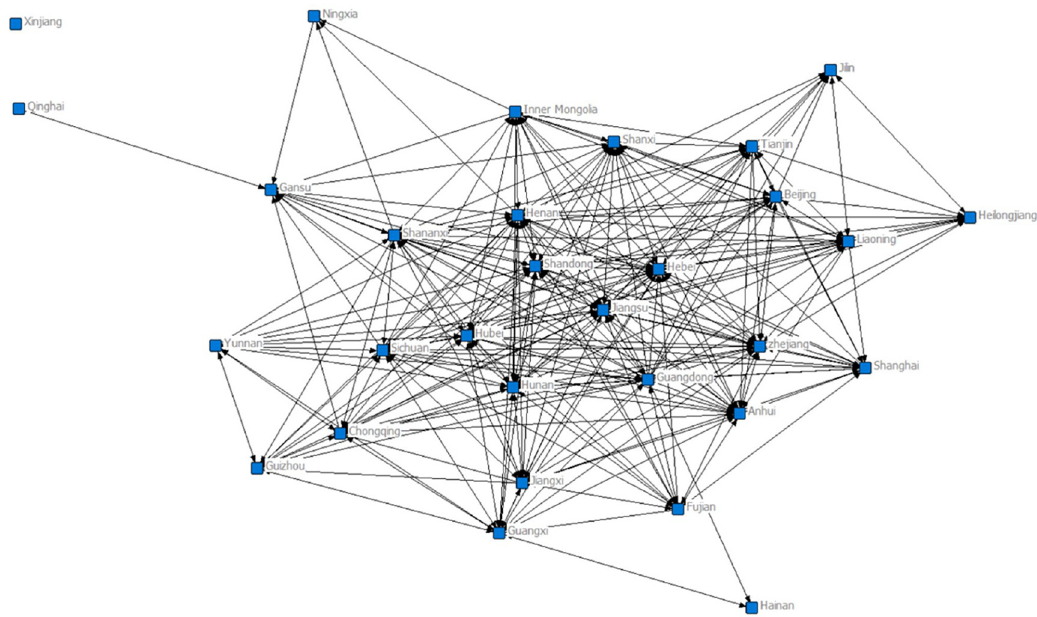
Fig 8. Topology of the 30-city converged network in 2012.